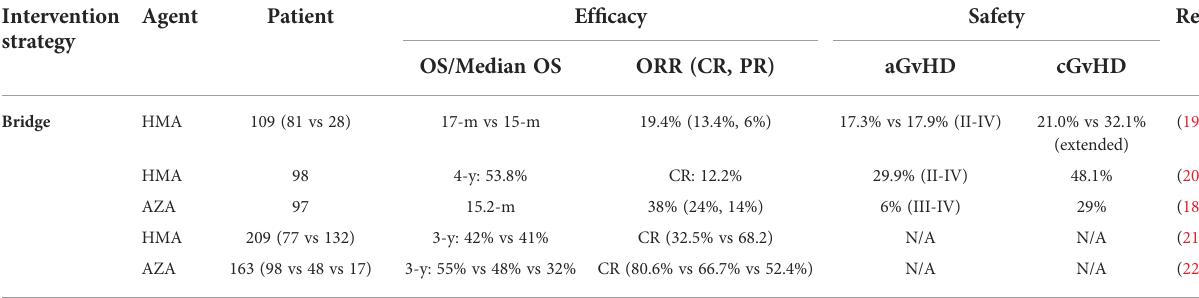
TABLE 1 The use of hypomethylating agents prior to hematopoietic stem cell transplantation in MDS or AML. Intervention